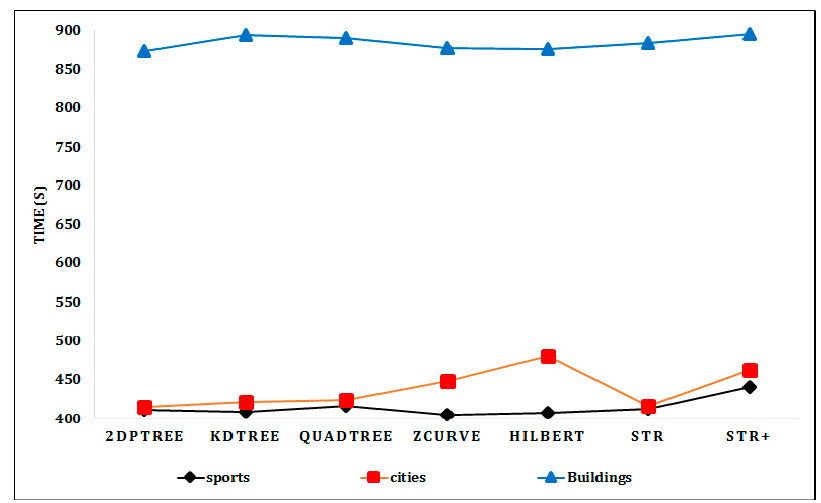
Figure 5. Indexing time for the synthetic datasets.